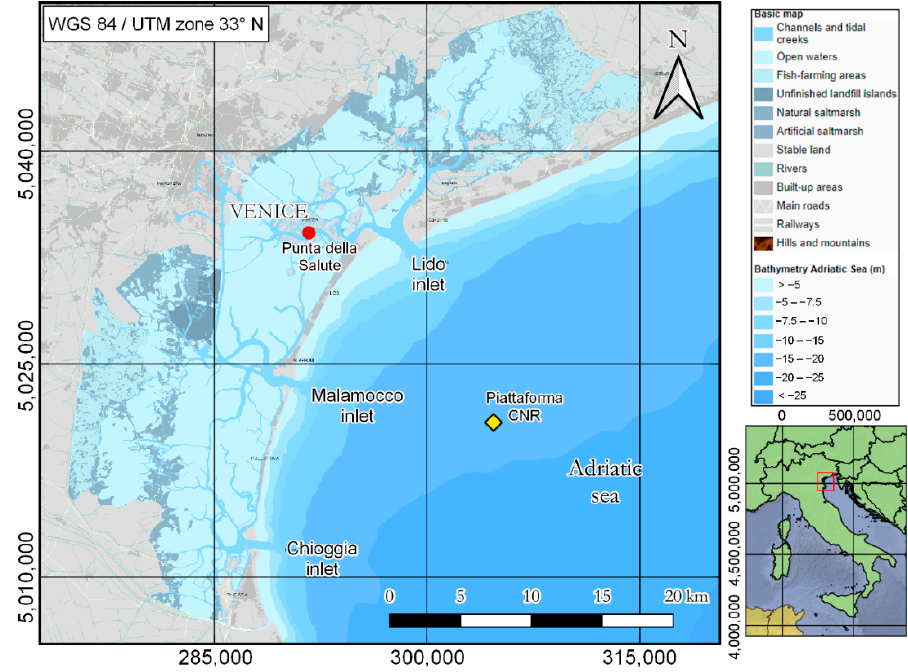
Figure 1. Location of the Punta della Salute tide gauge ( ) and Piattaforma CNR weather station ( ), with a thematic map of the Venice Lagoon [27].